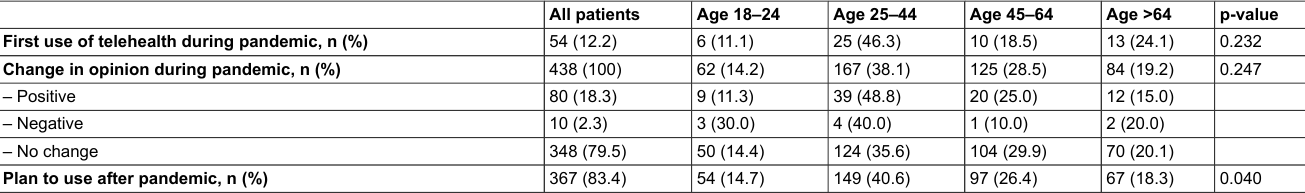
Table 3: Influence of the COVID–19 pandemic on telehealth use. First use during pandemic n = 442, plan to use after pandemic n = 440.